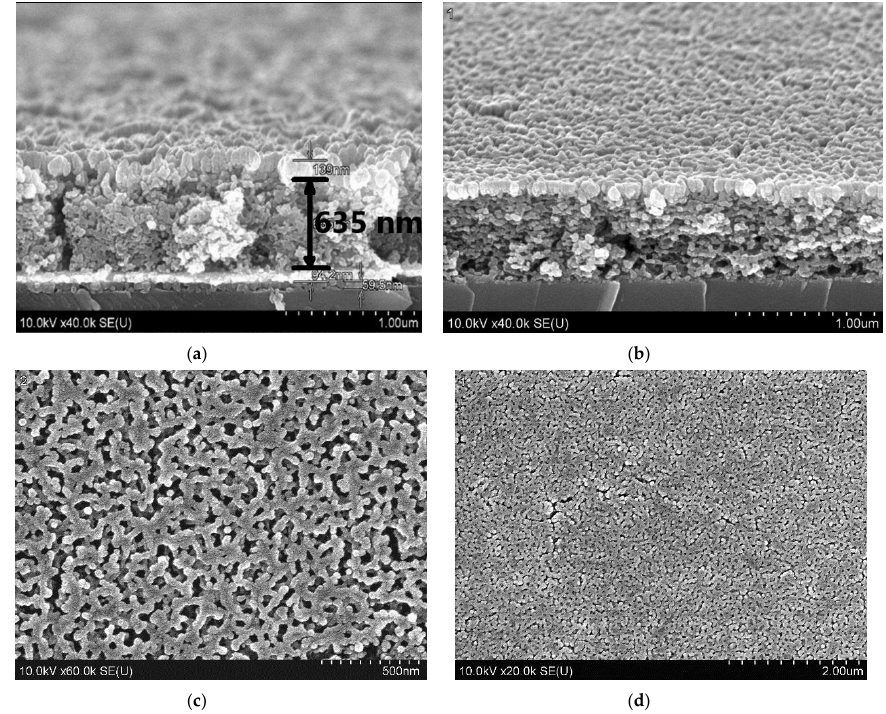
Figure 3. SEM images of Si/TiO x /Pt/SrTiO 3 /Ni ( a ), Si/SrTiO 3 /Ni ( b ) heterostructures, the surfaces of SrTiO 3 ( c ) and Ni electrode ( d ).